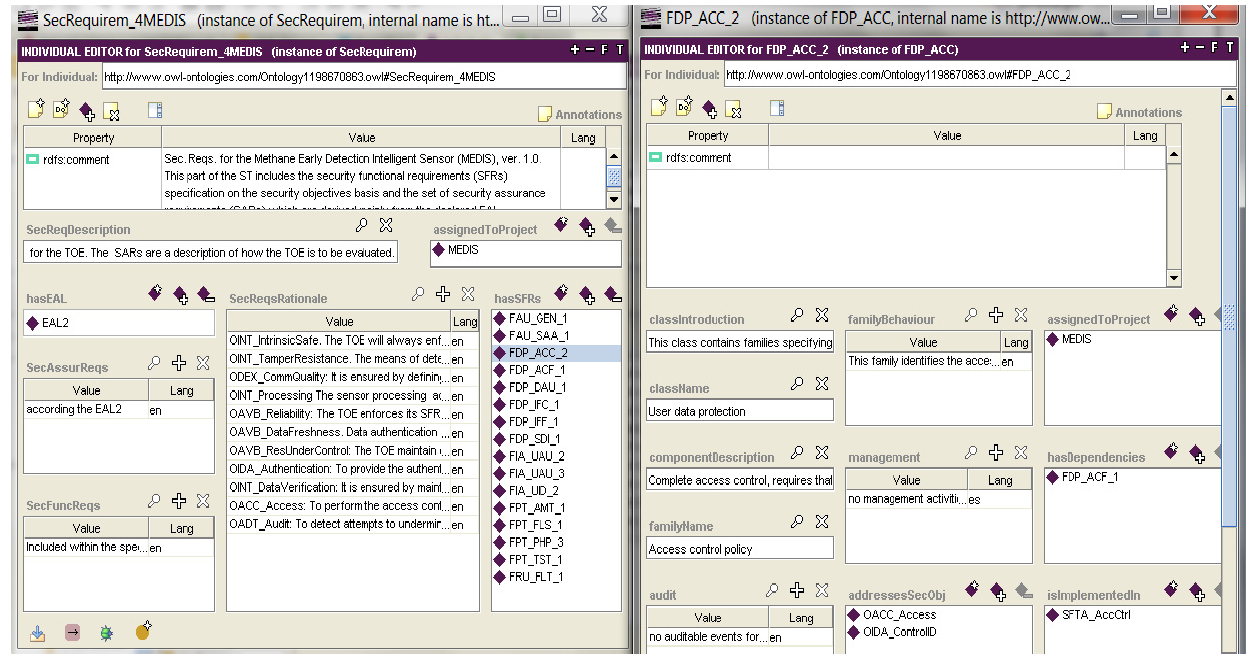
Figure 7. The security functional requirements and their particular